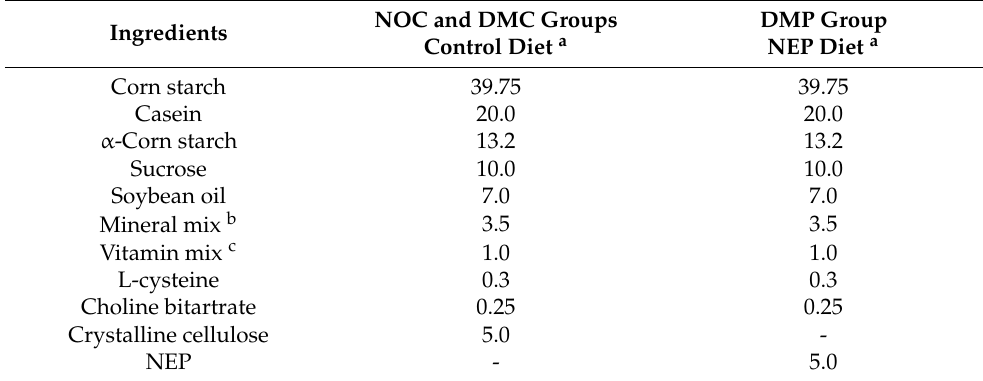
Table 1. Compositions of diets